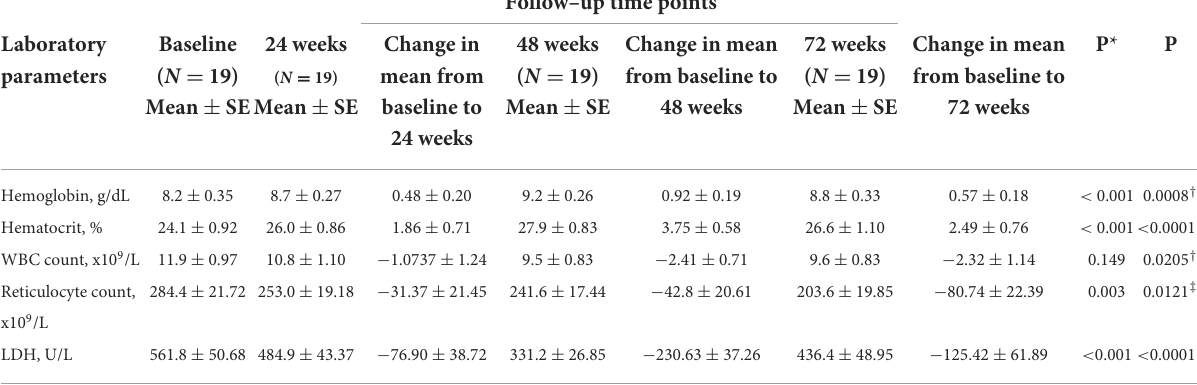
TABLE 3 Laboratory parameters of patients with sickle cell disease (SCD) at baseline and follow–up time points.